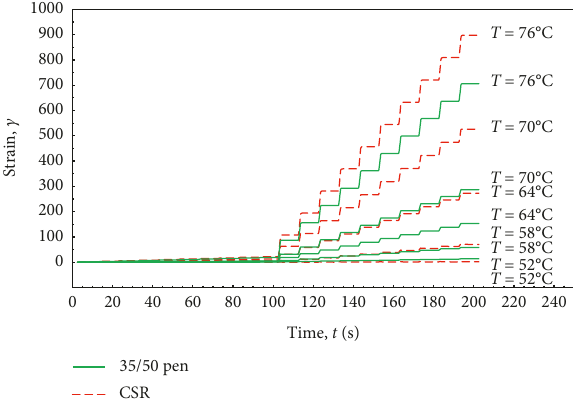
Figure 23: MSCR test results ( c vs. t )—35/50 pen vs. CSR strain